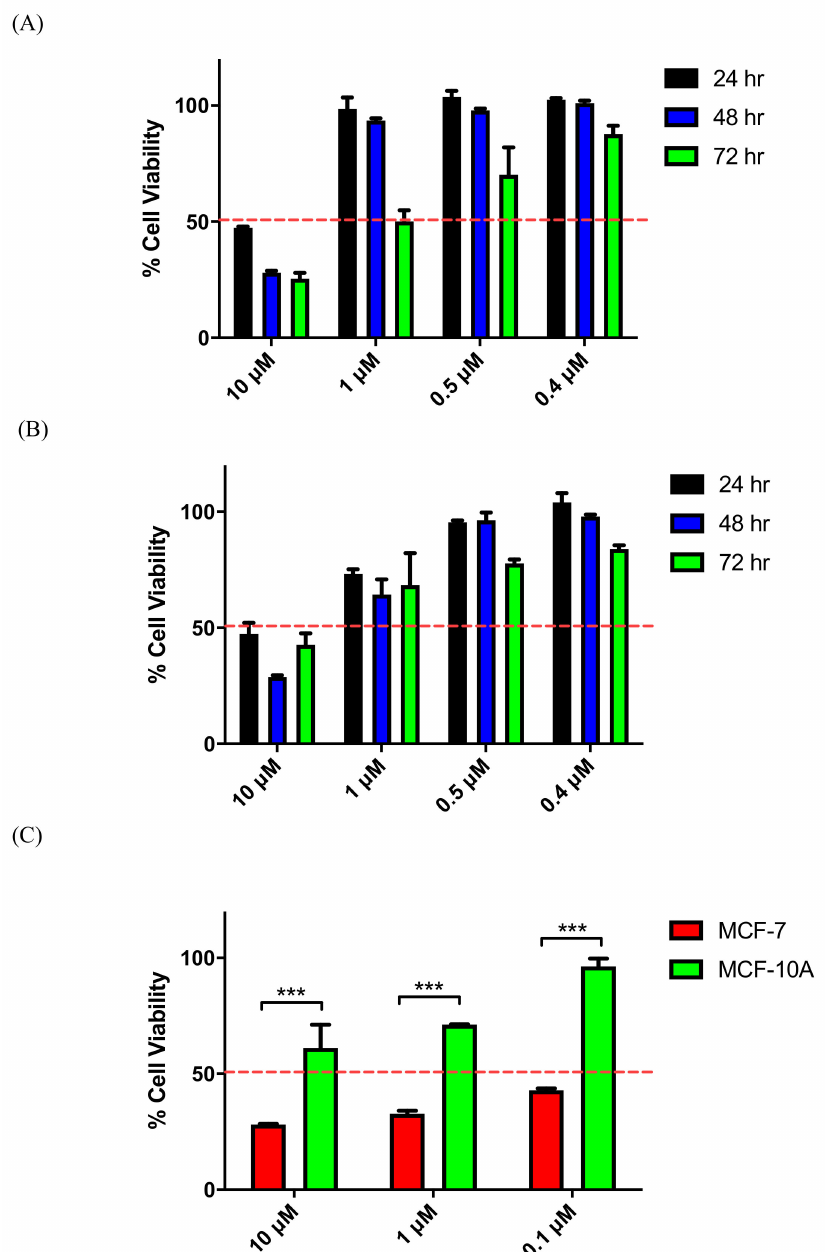
Figure 7. Screening of phenstatin derivatives 19e ( A ) and 21l ( B ) in MCF-10A cells at 24, 48, 72 h and ( C ) 24 in MCF-10A and MCF-7 cells at 72 h. ( A , B ) Effect of compounds 19e and 21l on the viability of non-tumorigenic MCF-10A human mammary epithelial cells. Cells were treated with the indicated concentrations for 21, 48, or 72 h. Cell viability was expressed as a percentage of vehicle control (ethanol 1% ( v / v )) and was determined by alamarBlue assay (average + SEM of three independent experiments). ( C ) Effect of compound 24 on the viability of non-tumorigenic MCF-10A human mammary epithelial cells and MCF-7 breast cancer cells. Cells were treated with the indicated concentrations for 72 h. Cell viability was expressed as a percentage of vehicle control (ethanol 1% ( v / v )) and was determined by alamarBlue assay (average ± SEM of three independent experiments). Statistical analysis was performed using two-way ANOVA (***, p <